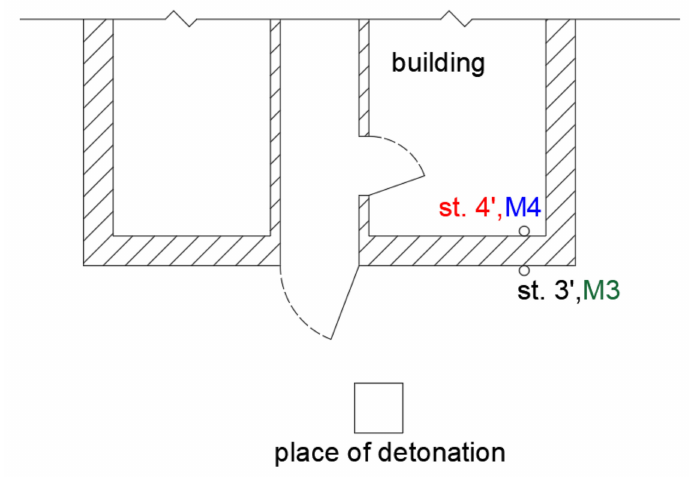
Figure 18. The sketch of location of measurement stations and explosives detonation.